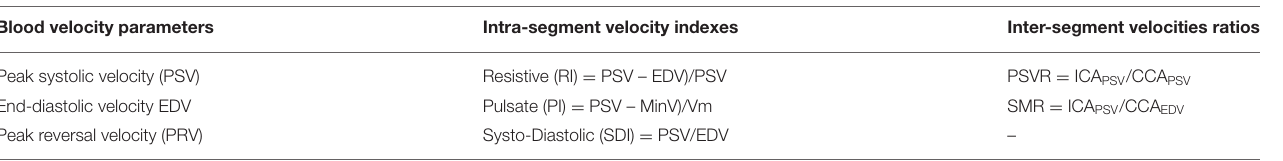
TABLE 1 | Blood flow velocity (BFV) and related